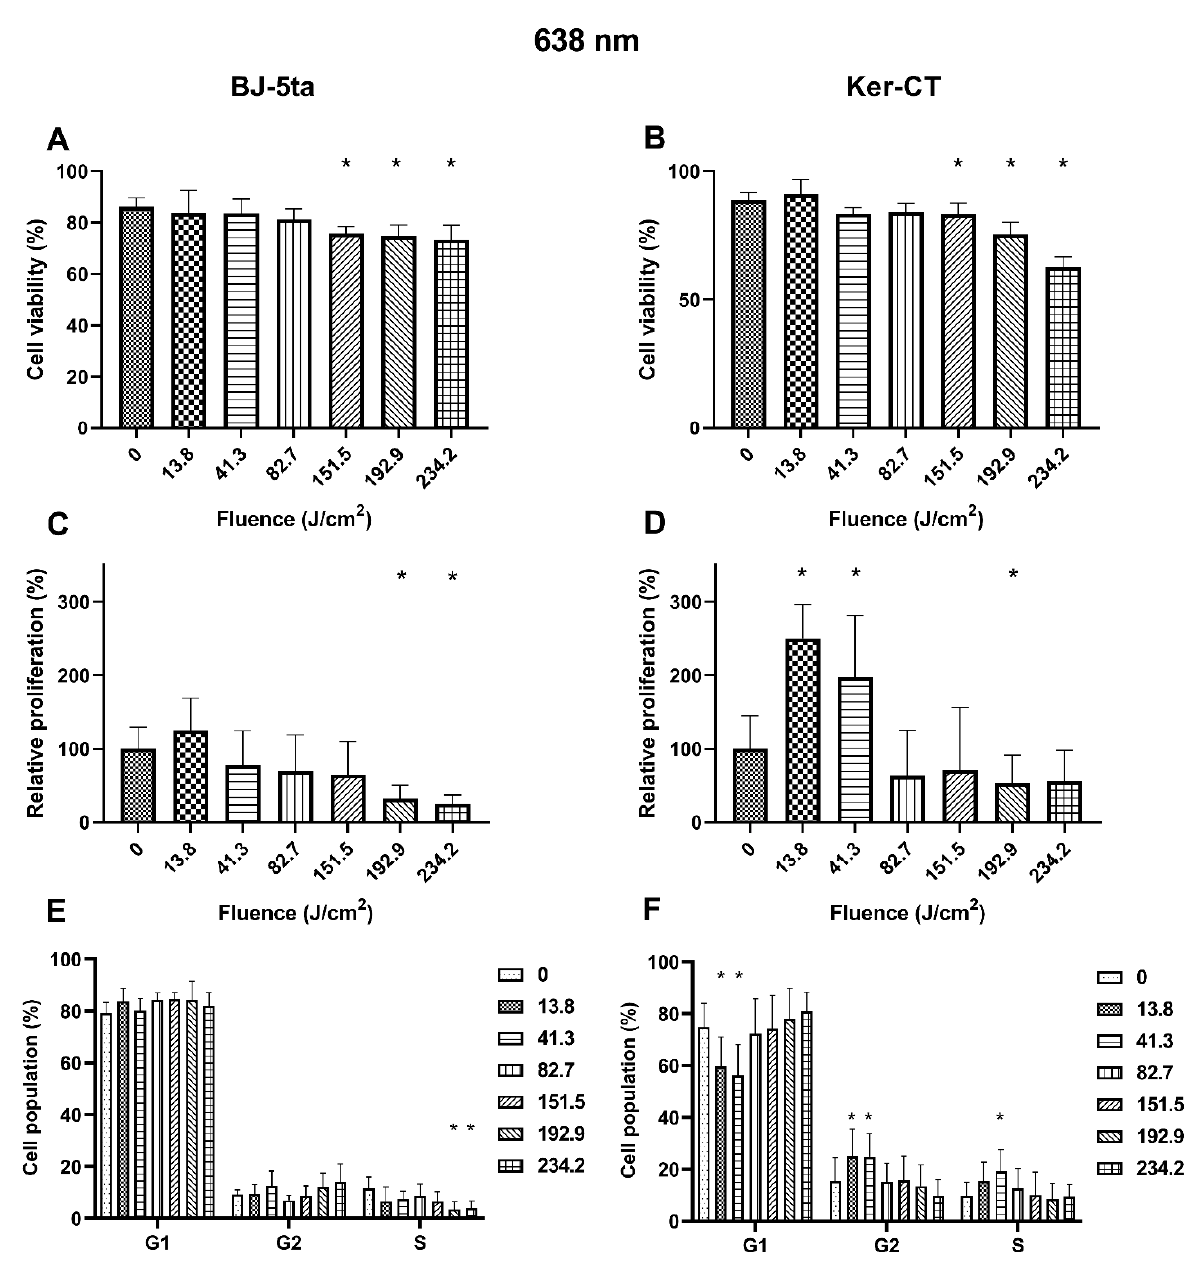
Figure 4. Effects of 638 nm irradiation on BJ-5ta fibroblasts and Ker-CT keratinocytes. ( A , B ) Viability using Annexin V-APC and PI. ( C , D ) Relative proliferation using an anti-Ki67-APC antibody. ( E , F ) Cell cycle distribution using FxCycle PI/RNase Staining Solution. * p <